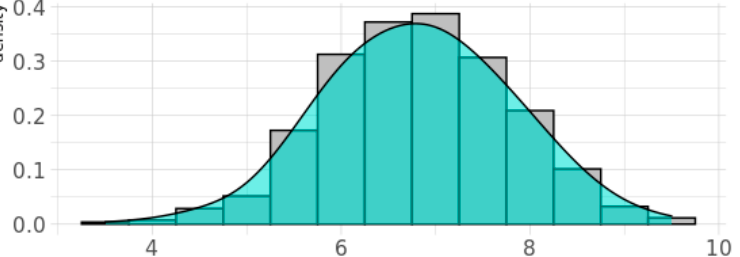
Figure 2. Density plot for the genetic pathway function score for oxidative stress response (gPFS ox ) in the BIS cohort. Note: Y-axis gives the probability density function for the kernel density estimation used to fit the curve. Table 2. The distribution of key characteristics in the Barwon Infant Study.